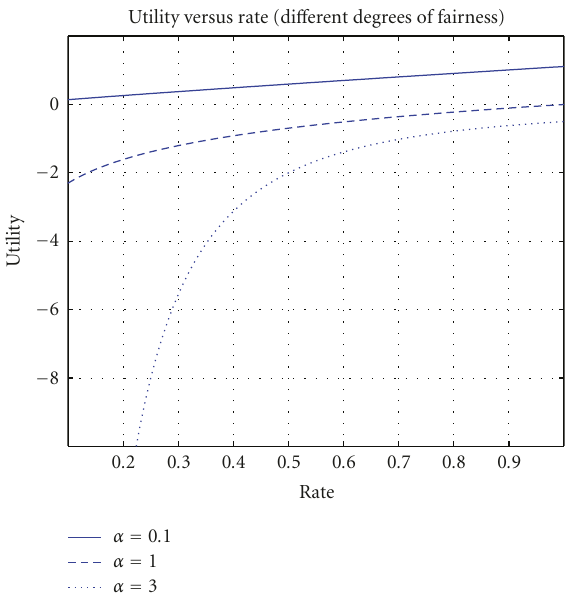
Figure 2: Di ff erent degrees of fairness ( α ) in the definition of utility